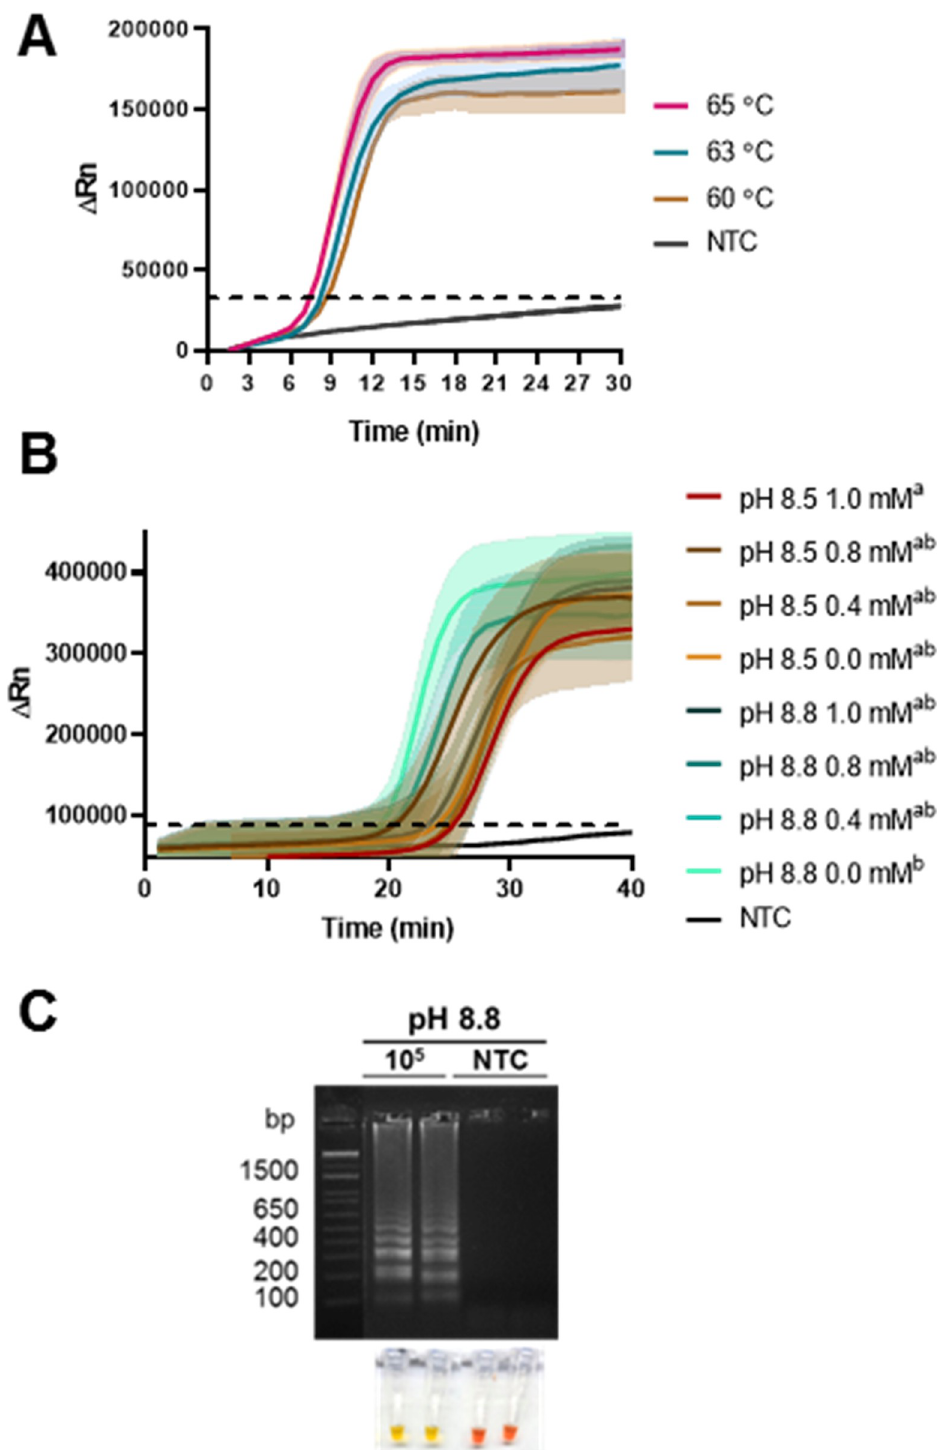
Fig 2. Optimization assays of RT-LAMP reaction conditions for SARS-CoV-2 detection. (A) Real time LAMP reactions evaluating the effect of temperature on amplification. (B) Real time RT-LAMP reactions at different pH and concentration of Tris-HCl. (C) Colorimetric RT-LAMP reactions at pH 8.8 in the absence of Tris-HCl in the reaction buffer. The figure shows the electrophoretic profile of the amplification reaction products (upper panel) and the colorimetric determination of each reaction (lower panel). NTC: non-template control; M: DNA molecular weight